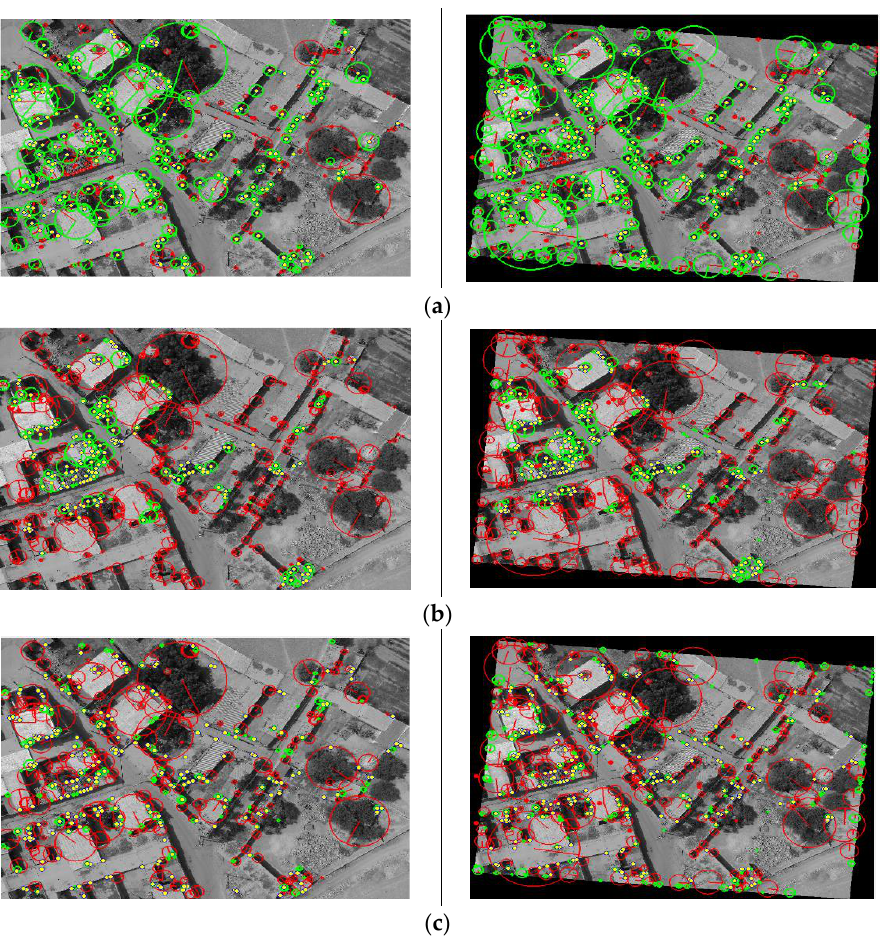
Figure 6. An example of the keypoint selection for an image pair for SIFT detector, ( a ) SIFT-entropy, ( b ) SIFT-saliency, ( c ) SIFT-texture-coefficient.